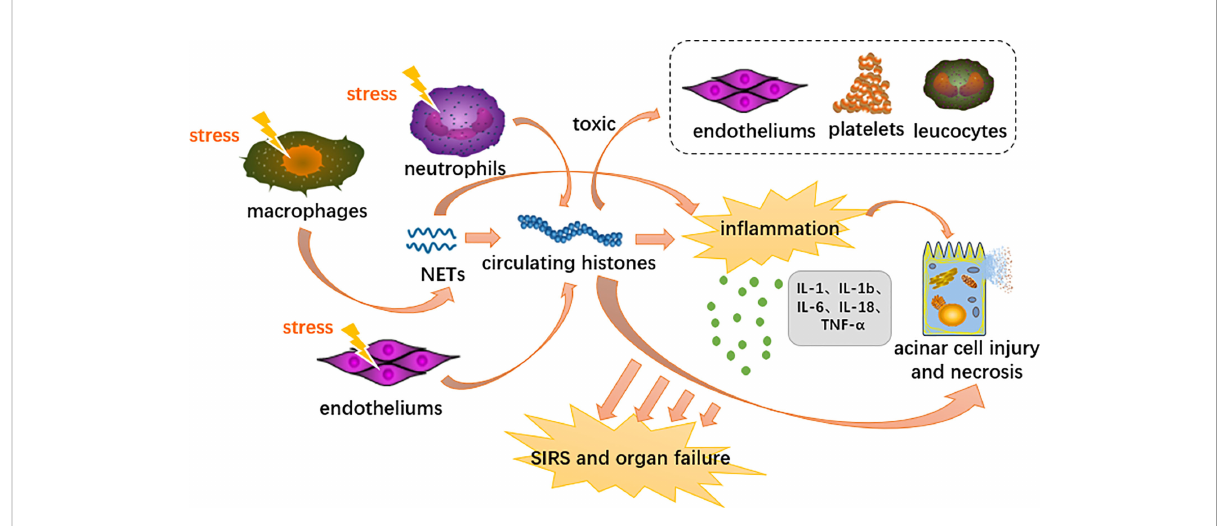
FIGURE 3 Proposed immunopathological roles of circulating histones in acute pancreatitis. DAMPs activate innate immune cells (neutrophils and macrophages) and endothelial cells through PRRs, triggering highly in fl ammatory programmed cell death such as neutrophil extracellular traps, necroptosis and necrosis. Extracellular histones mediate in fl ammation response, organ injury and death through TLR and NLRP3 in fl ammasome